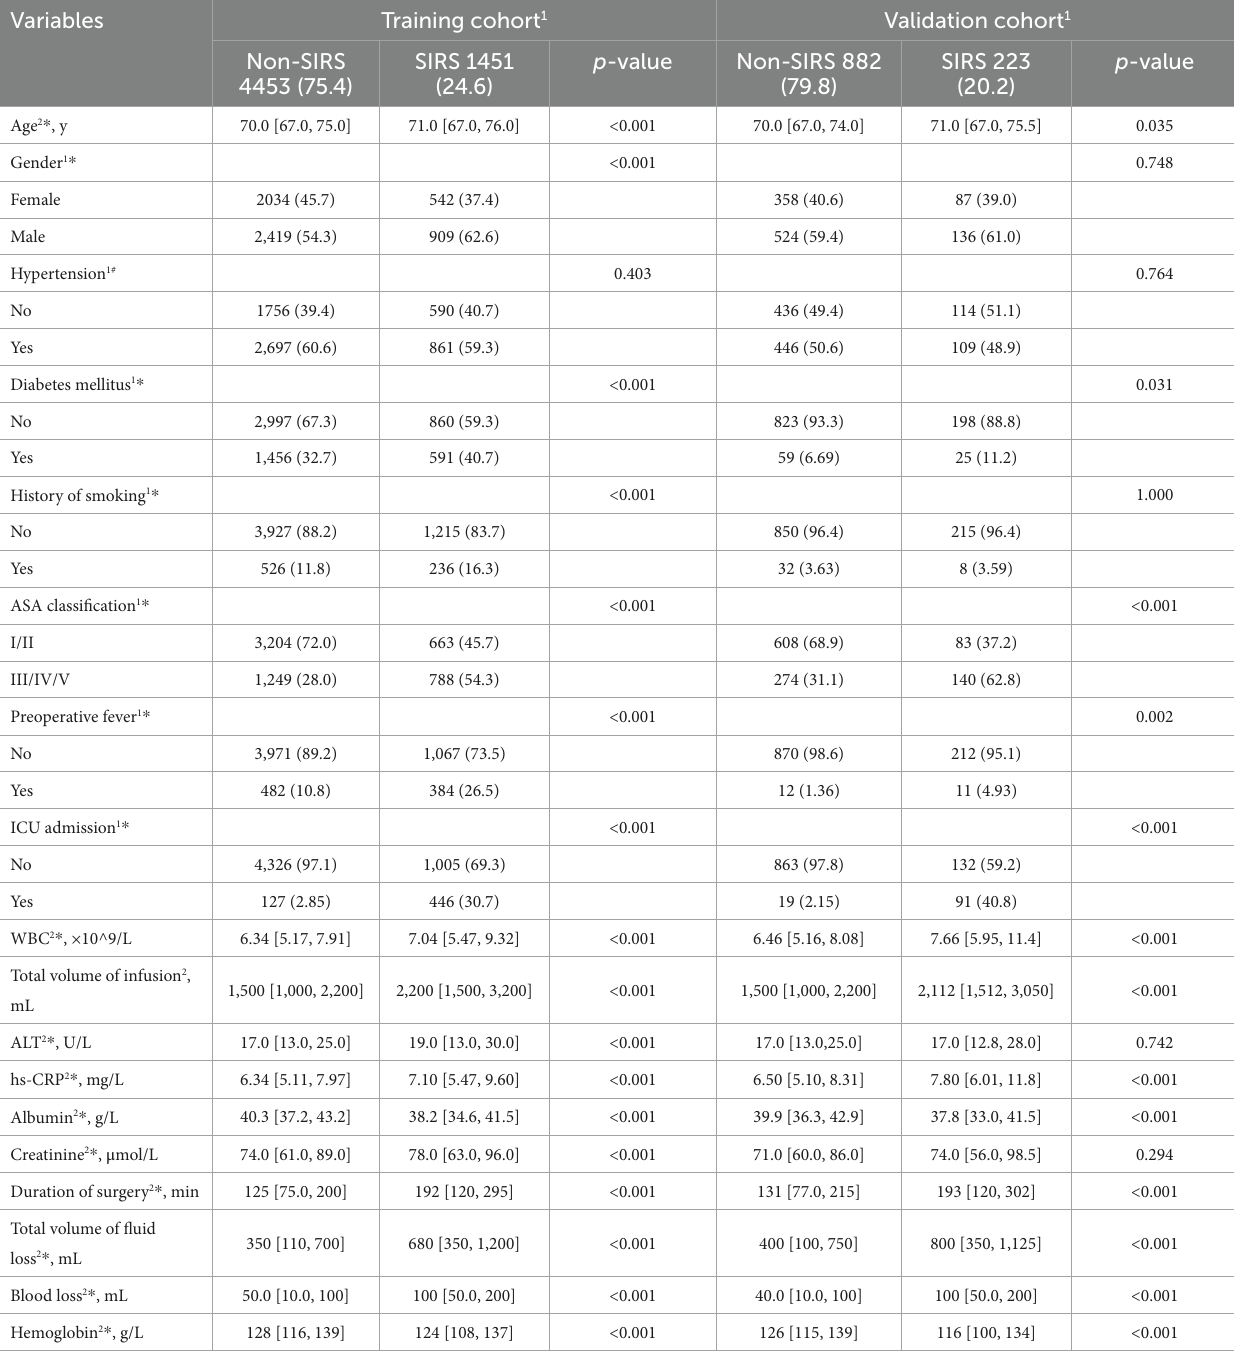
TABLE 1 Patient characteristics of non-SIRS and SIRS